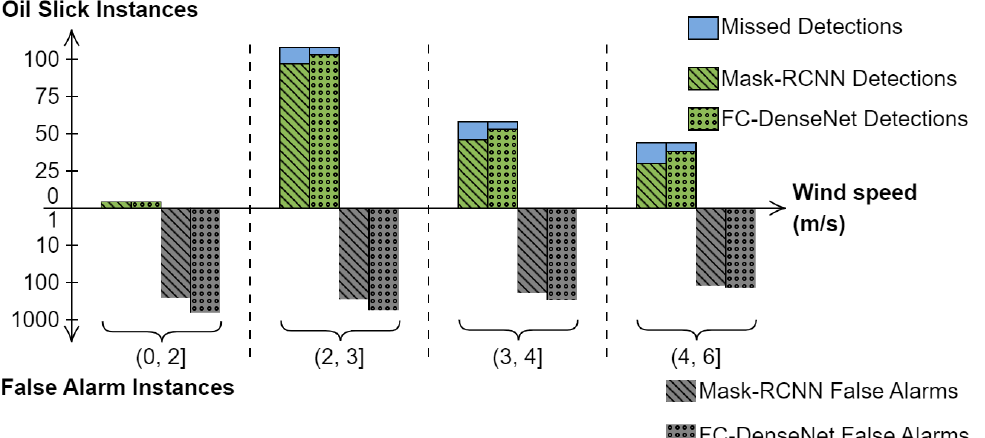
Figure 14. Detection performance of the improved version of FC-DenseNet and Mask R-CNN as a function of wind speed (m/s). Green bars represent good detection; blue shows missed detection. False alarms are represented by gray bars on a logarithmic